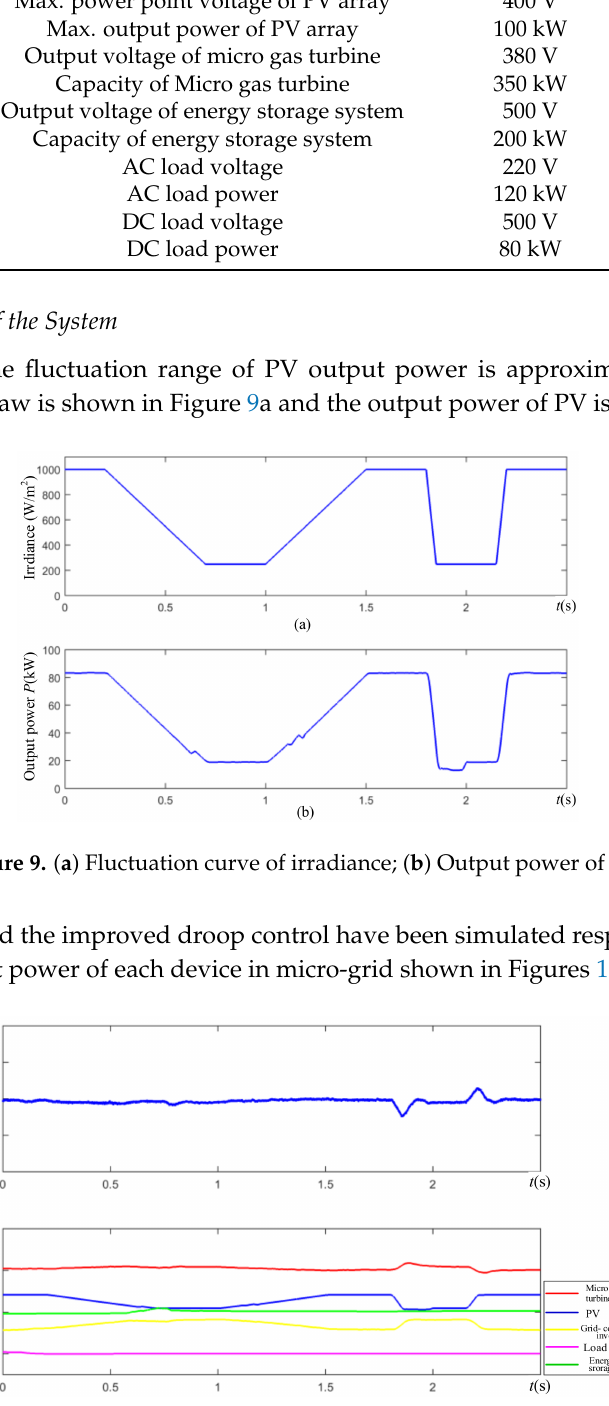
Figure 10. System response with traditional droop